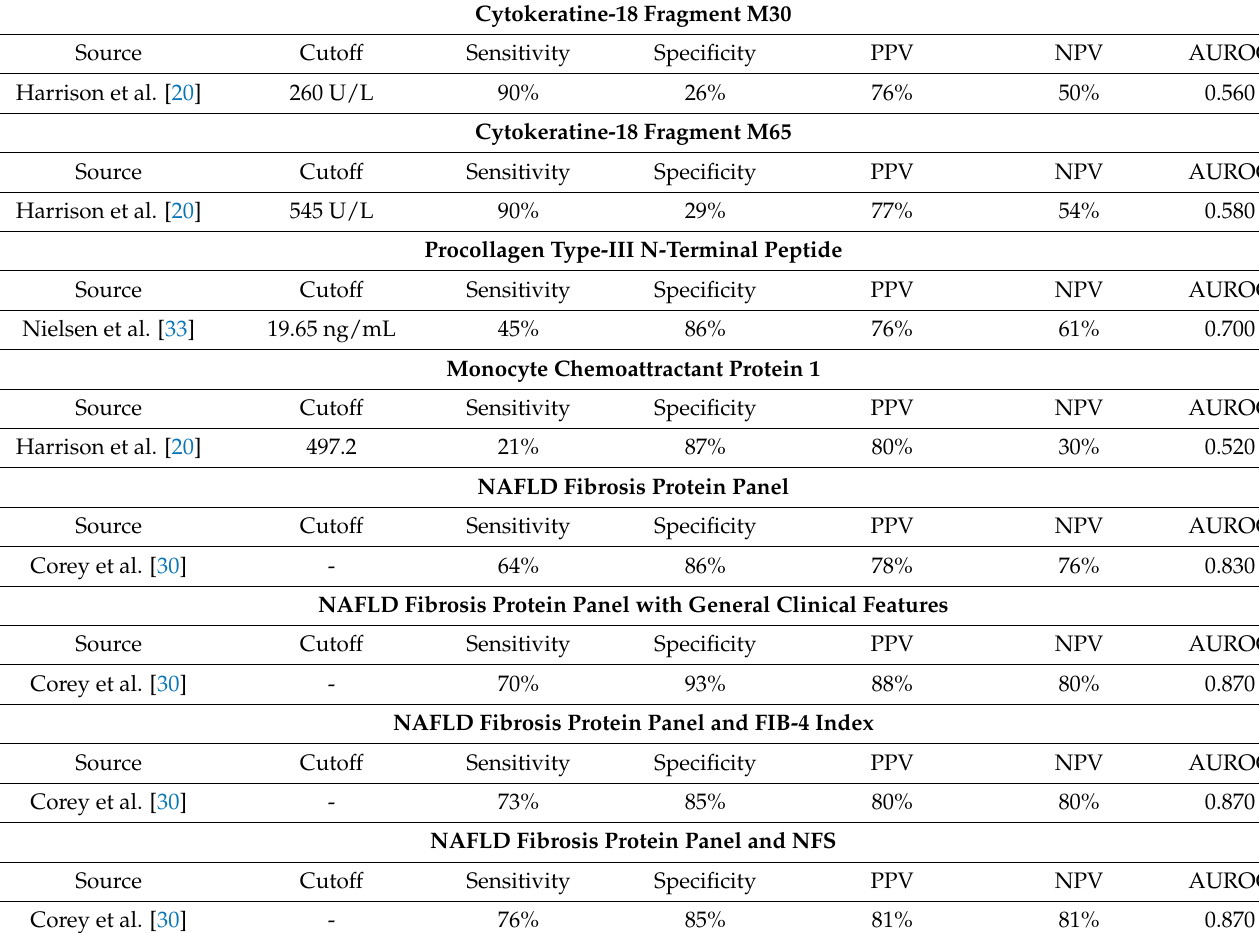
Table 8. Diagnostic performance of novel biomarkers in the detection of significant fibrosis. Cytokeratine-18 Fragment